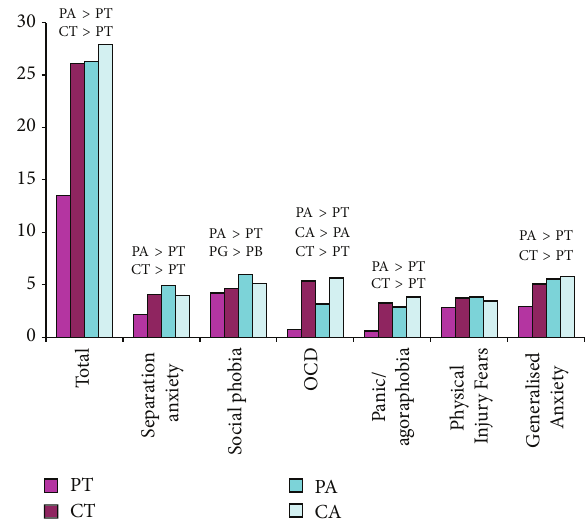
Figure 1: Means of the SCAS total and subscales for parents